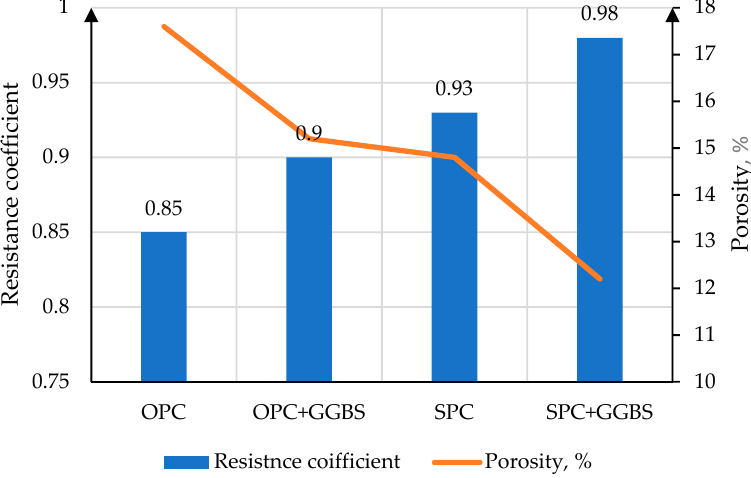
Figure 22. Dependence of compressive strength on exposure time in 2% H 2 SO 4 solution.